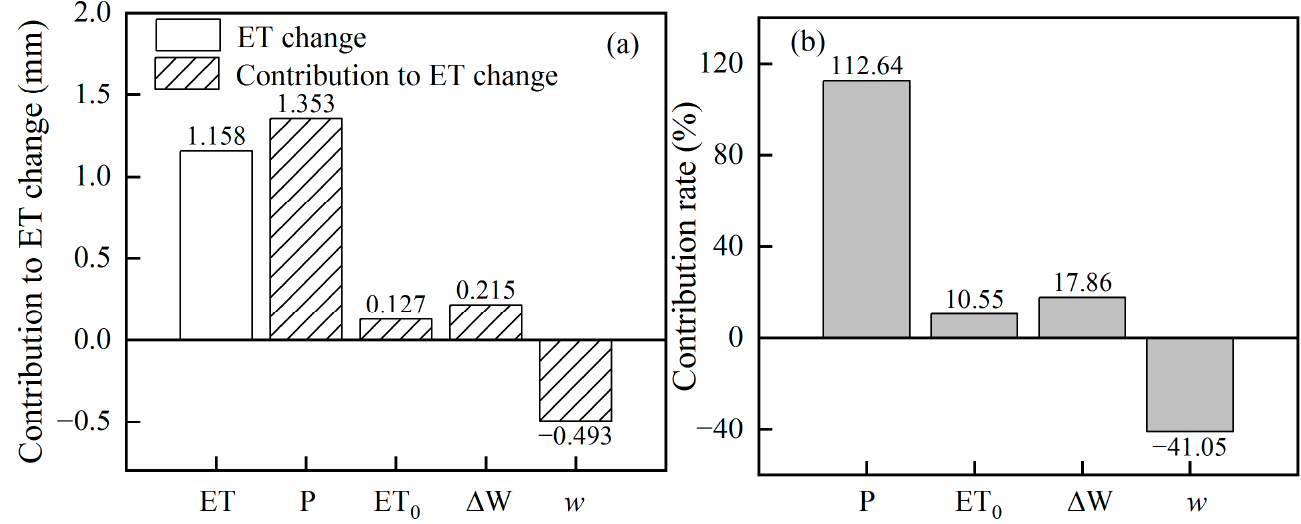
Figure 5. Contributions ( a ) and contribution rates ( b ) of the variation in P, ET 0 , ∆ W, and w to ET variation.